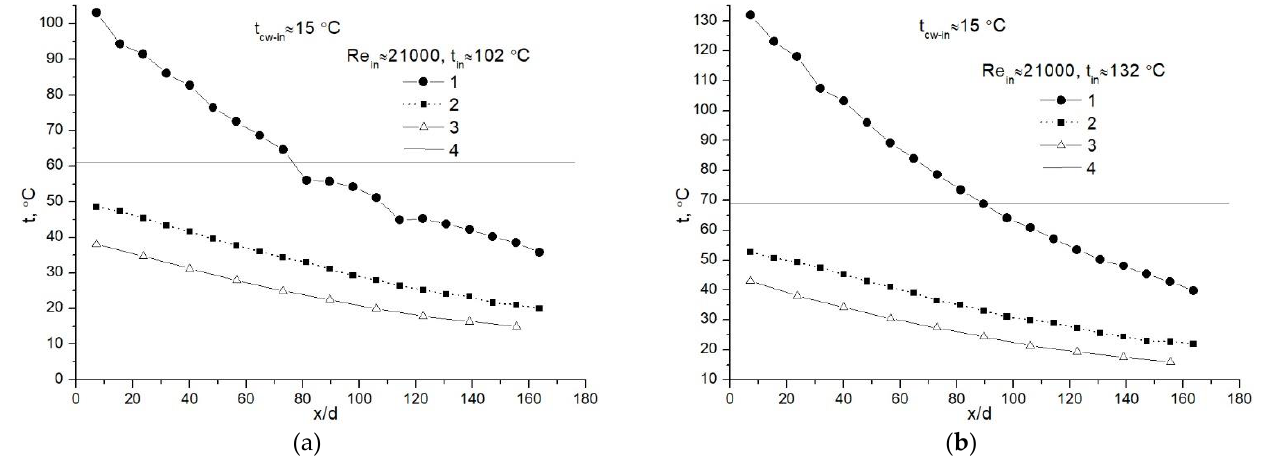
Figure 12. Temperature distribution in heat exchanger at Re in ≈ 21,000, flue gas temperatures ( a ) t in ≈ 102 °C, ( b ) t in ≈ 132 °C, and similar cooling water inlet temperatures: (1) center of the tube, (2) the inner wall of the tube, (3) cooling water, (4) the dew point temperature.